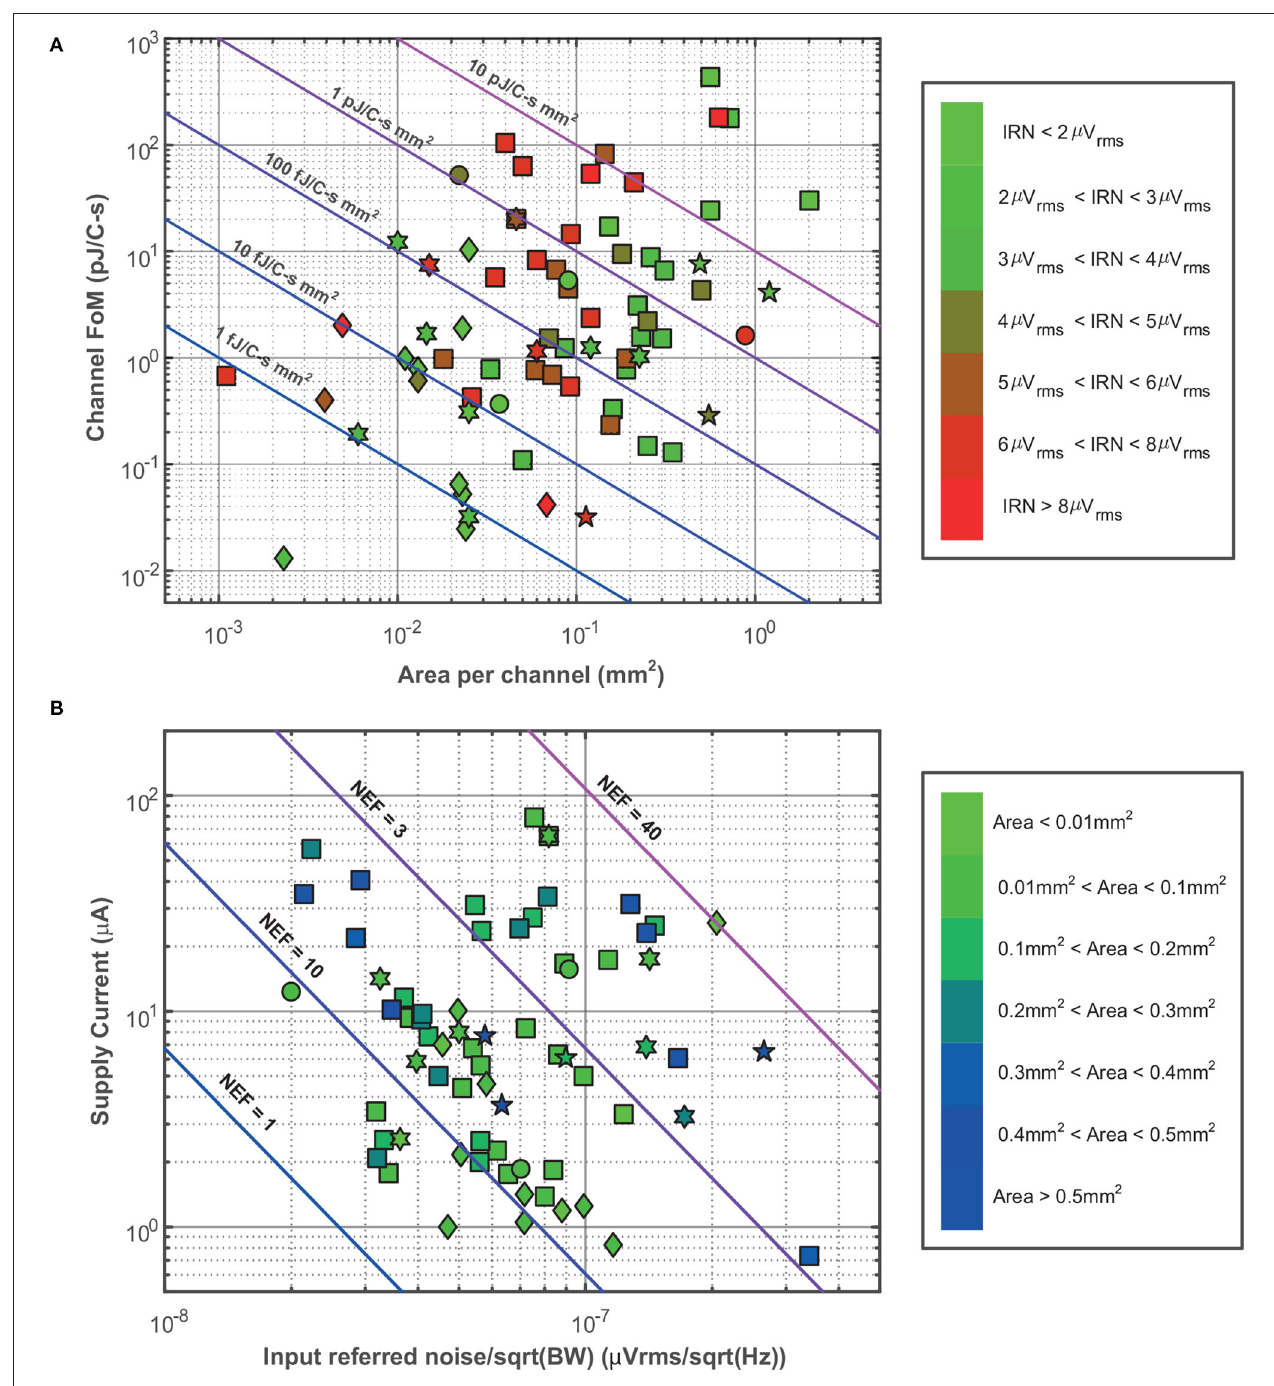
FIGURE 7 | Comparison of state-of-the-art LNAs and AFEs topologies in terms of Channel FoM and normalized IRN. (A) Channel FoM vs. area per channel comparison. The green-red scale indicates the value of the IRN of each reported circuit. The lines shows different FoM per area values as references. (B) Supply current vs. normalized IRN comparison. The green-blue scale indicates the value of the occupation area of each reported circuit. The lines show different NEF values as references. The employed symbol code is the same as shown in Figure 6 .